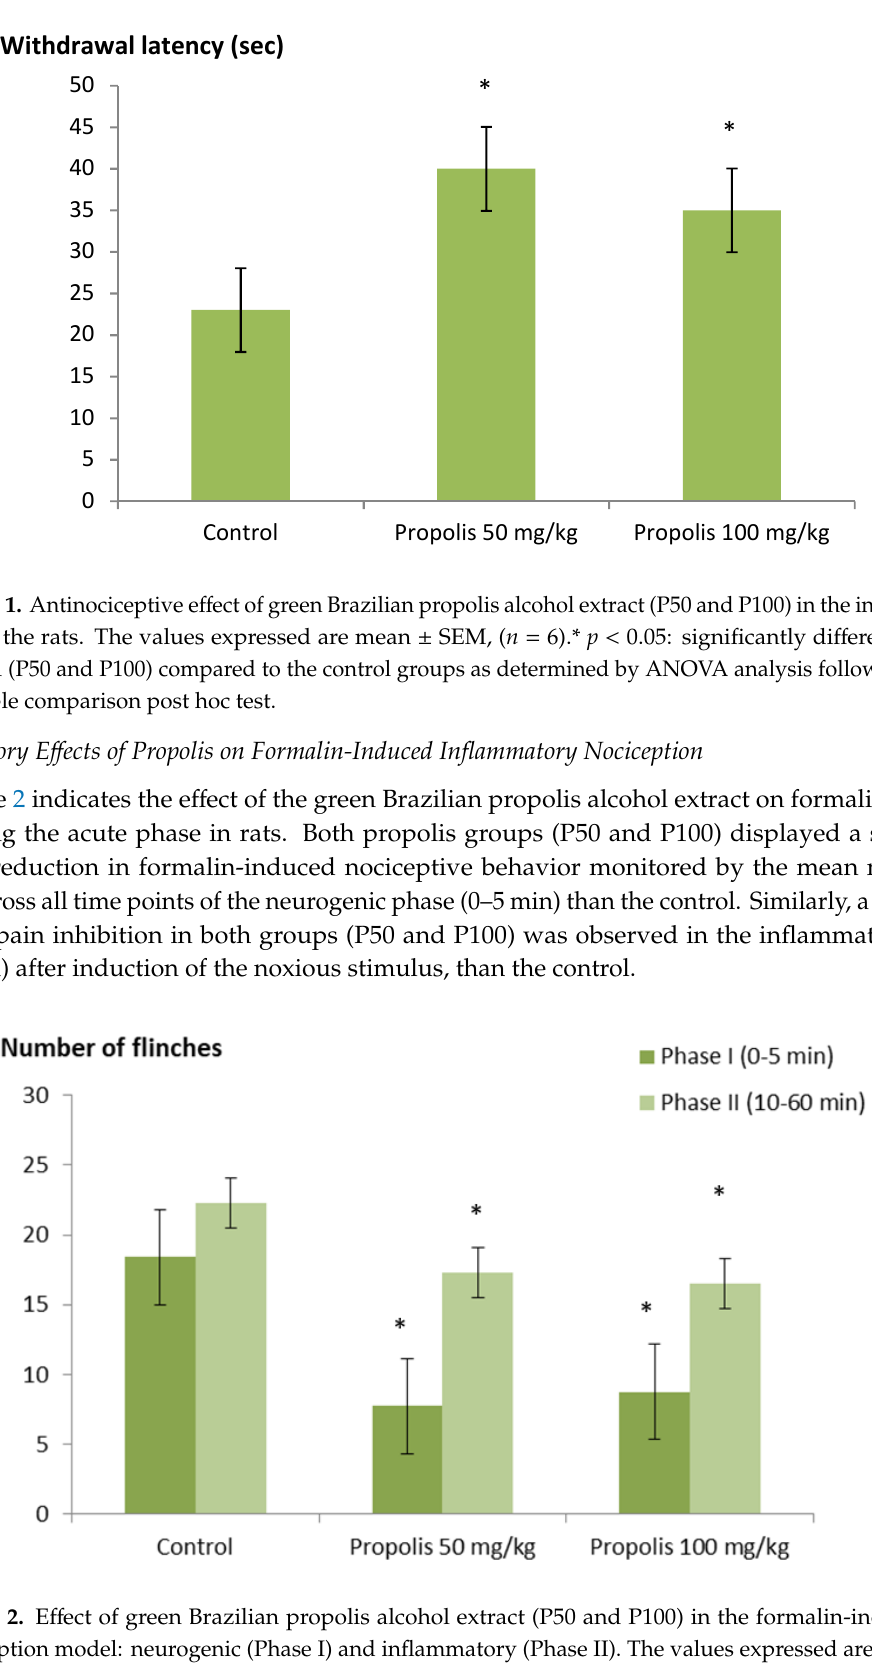
Figure 2. Effect of green Brazilian propolis alcohol extract (P50 and P100) in the formalin-induced nociception model: neurogenic (Phase I) and inflammatory (Phase II). The values expressed are mean ± SEM, ( n = 6). * p < 0.05: significantly different for treated (P50 and P100) compared to the control groups as determined by ANOVA analysis followed by multiple comparison post hoc test.